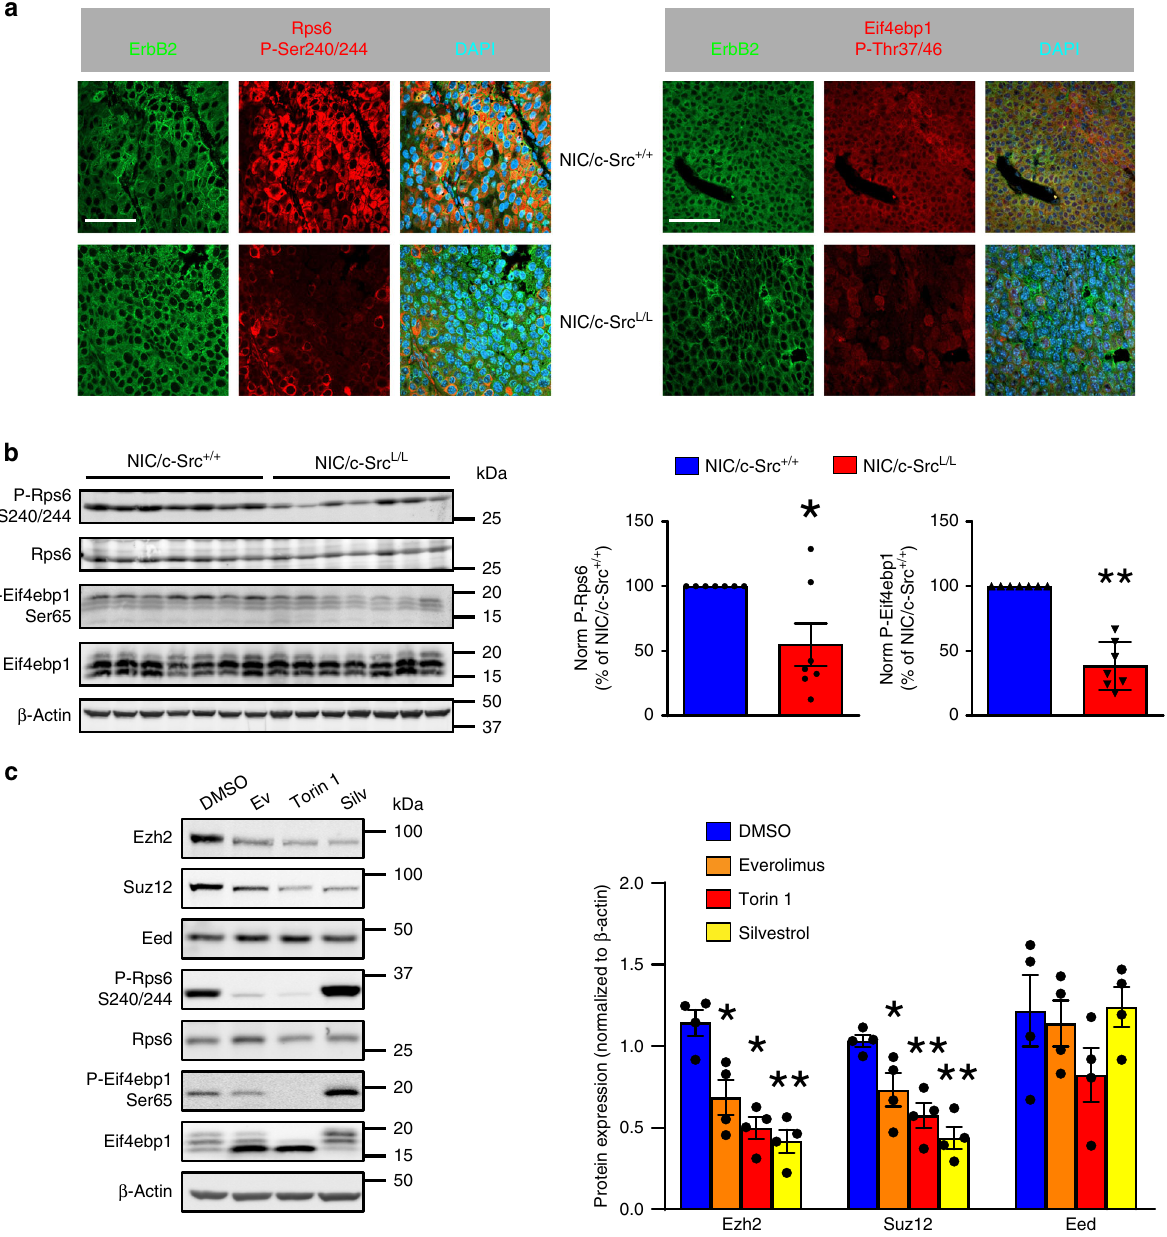
Fig. 3 mTORC1 activity is impaired in ErbB2 + breast cancer cells lacking c-Src. a IF analysis of ErbB2 and phosphorylated forms of Rps6 and Eif4ebp1 in control and c-Src-de fi cient ErbB2 + mammary tumors. Scale bars represent 50 µ m. b Left panel – immunoblots of Rps6 and Eif4ebp1 phosphorylation in control and c-Src-de fi cient ErbB2 + mammary tumors. Right panel - bar charts show quanti fi cation of phosphorylated Rps6 and Eif4ebp1 proteins ( n = 7 tumors per genotype). c Left - representative immunoblots of PRC2 expression and mTORC1 signaling in NIC/c-Src + / + ErbB2 + breast cancer cells treated with the indicated inhibitors for 24 h (Ev: everolimus, 10 nM; Torin 1, 250nM; Silv: silvestrol, 25 nM). Right - Quanti fi cation of Ezh2, Suz12 and Eed protein levels in four independent cell lines following the indicated treatments. All data in this fi gure are presented as mean ± SEM, where * = p < 0.05 and ** = p < 0.01; unpaired, two-tailed Student ’ s t